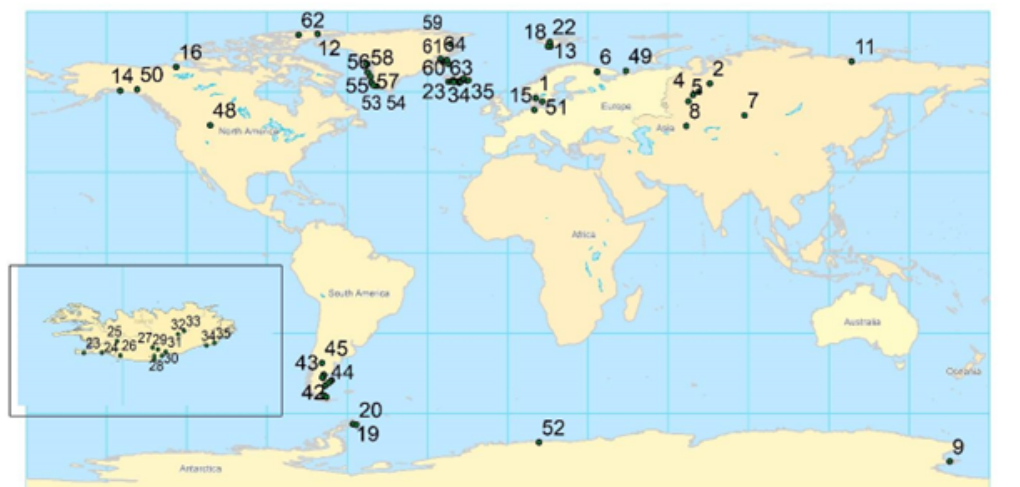
Figure 1. Map of the locations of the northern (north of 50 ◦ N) and southern (south of 40 ◦ S) high-latitude dust (HLD) sources identified and included in this study. The numbers are the identified 64 dust sources, as shown in Fig.